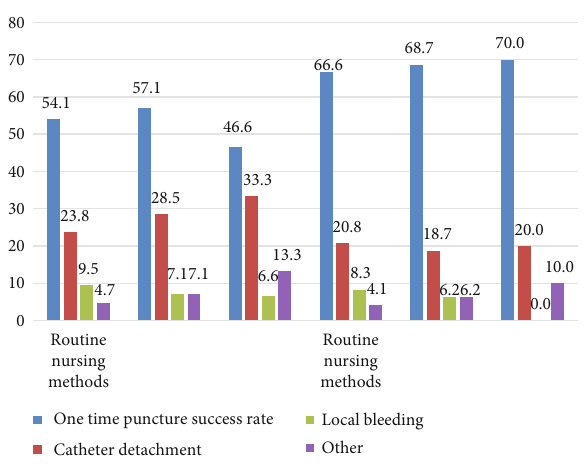
Figure 3: Visual comparison of nursing quality observation results of di ff erent treatment methods.